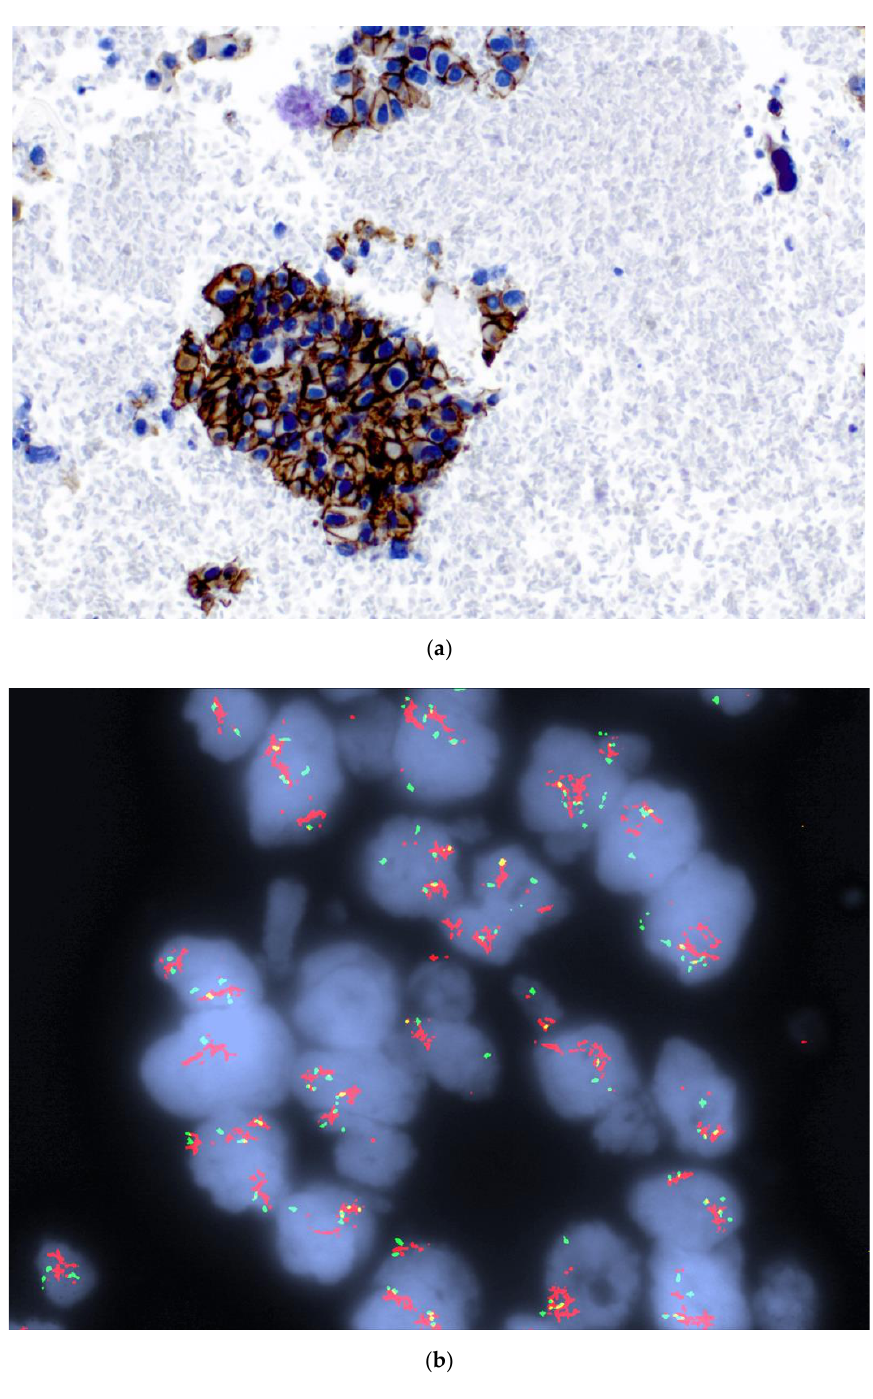
Figure 5. ( a ) Cell block shows metastatic breast carcinoma with strong circumferential overexpression (3+) of HER2 (immunohistochemical stain). ( b ) Cell block with HER2 -amplified breast carcinoma (dual-color fluorescent in situ hybridization, with centromere probe in green (CEP17) and HER2 gene in orange). Usual protocols for HER2 testing apply to cell block and core biopsy samples.